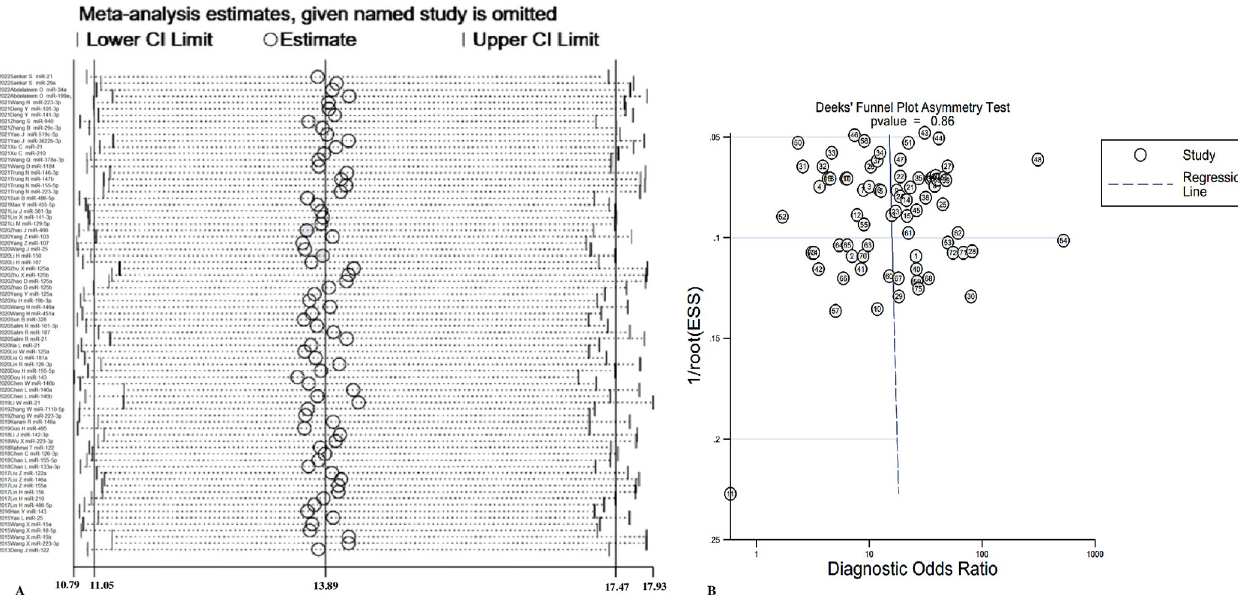
PLOS ONE | https://doi.org/10.1371/journal.pone.0279726 February 22, 2023 11 /